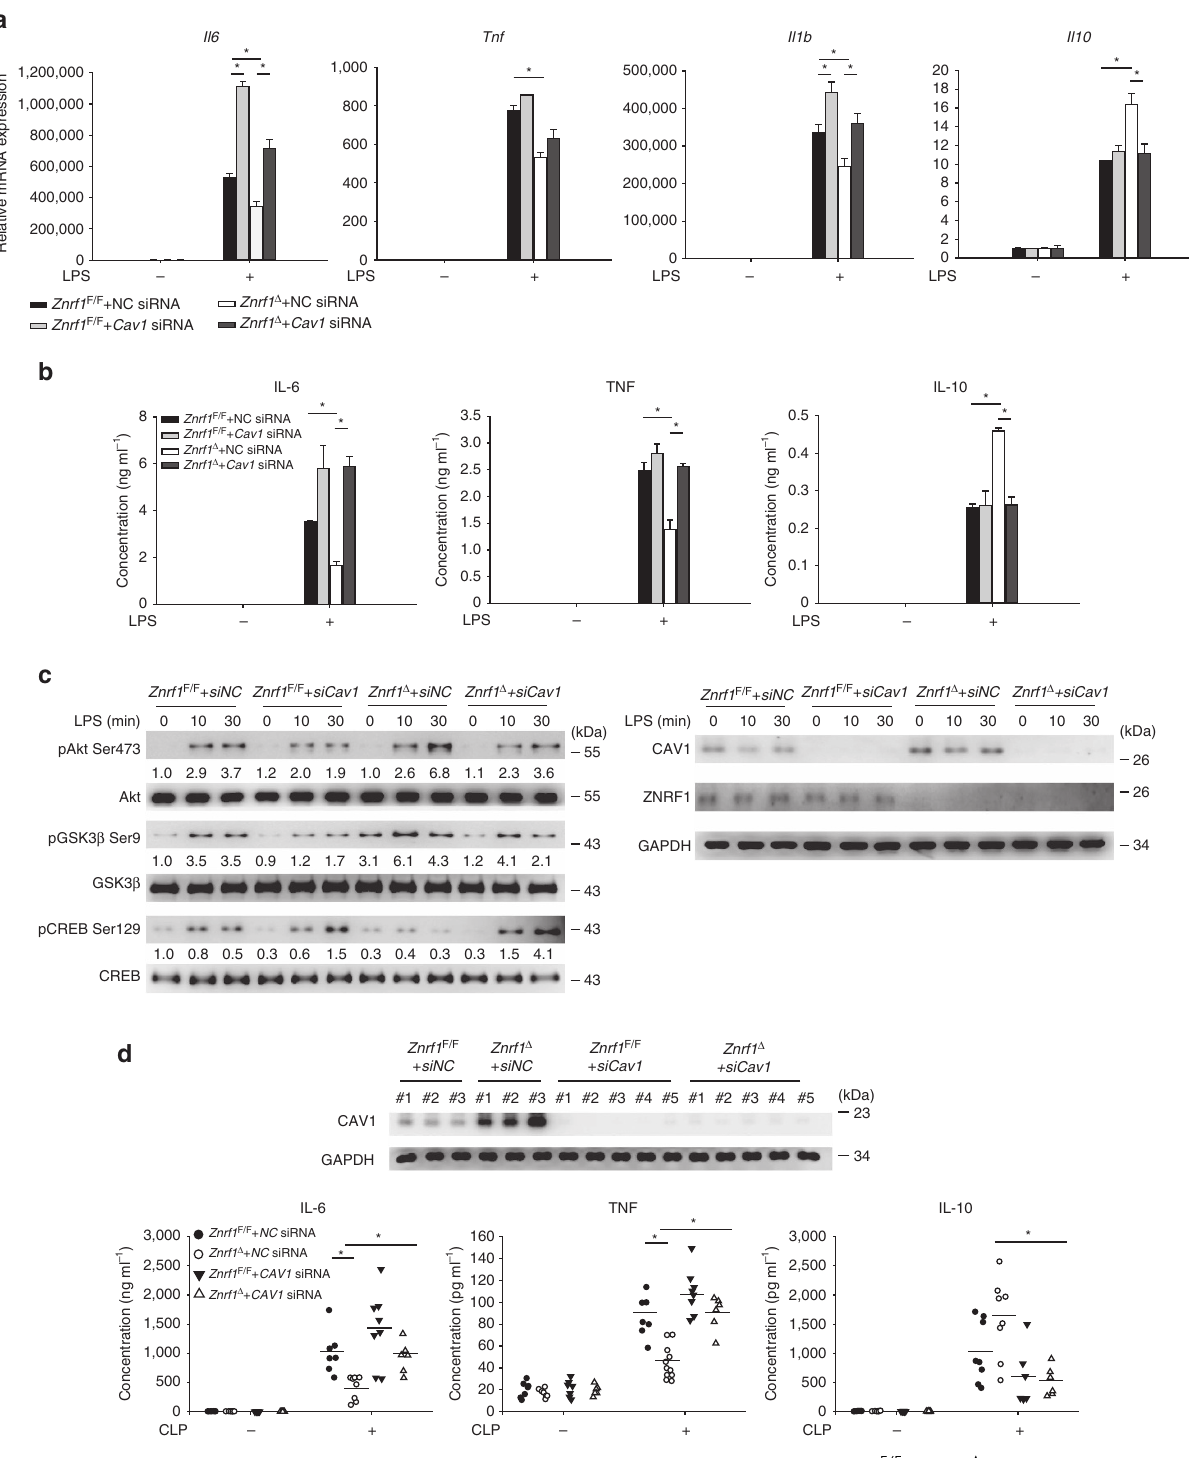
Figure 7 | ZNRF1-mediated TLR4- and CLP-triggered inflammatory responses depend on CAV1. ( a – c ) Znrf1 F/F or Znrf1 D BMDMs electroporated with either control ( NC) or Cav1 siRNA were treated with LPS (100ngml (cid:2) 1 ). ( a ) The expression of the indicated mRNAs in BMDMs after stimulation with LPS for 4h was analysed by RT–qPCR. ( b ) The production of cytokines in culture supernatants of BMDMs after treatment with LPS for 8h was determined by ELISA. ( c ) Phosphorylation of Akt, GSK3 b , and CREB as well as the indicated proteins in cell lysates were analysed by immunoblotting with the indicated antibodies. The intensities of the bands are shown as fold increases compared to those of untreated control cells after normalization to their unphosphorylated forms. The data are representative of three independent experiments performed in triplicate (error bars, s.d.). ( d ) Znrf1 F/F or Znrf1 D mice were injected intravenously with either control ( NC) or Cav1 siRNA. After 36h, mice were subjected to CLP, and blood was collected 8h post CLP. The indicated cytokines in sera were determined by ELISA (bottom), and CAV1 protein level in peripheral blood leukocytes were analysed by immunoblotting (top). * P o 0.05 (Student’s t